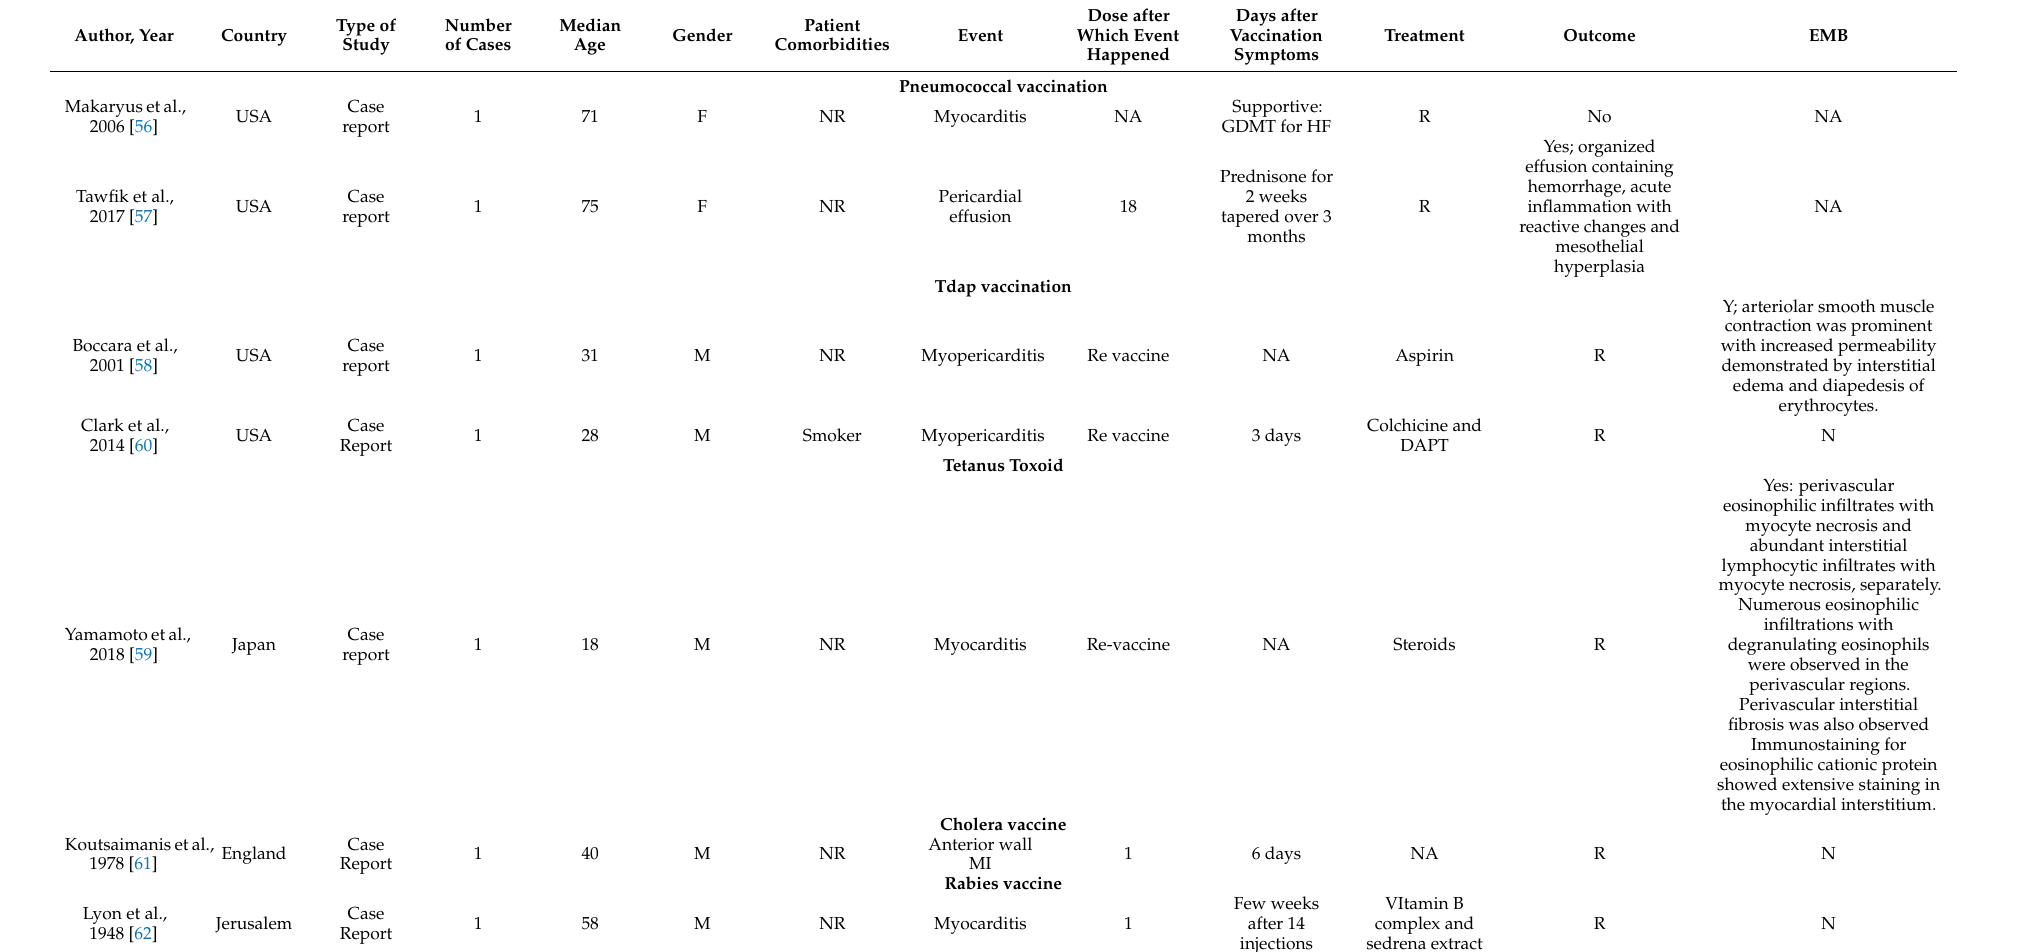
Table 5. Adverse events after other